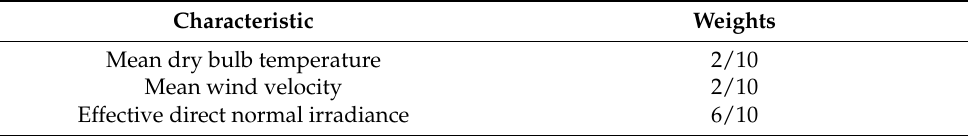
Table 1. Weather characteristics used in FS-statistic and nRMSD determination and the respec- tive